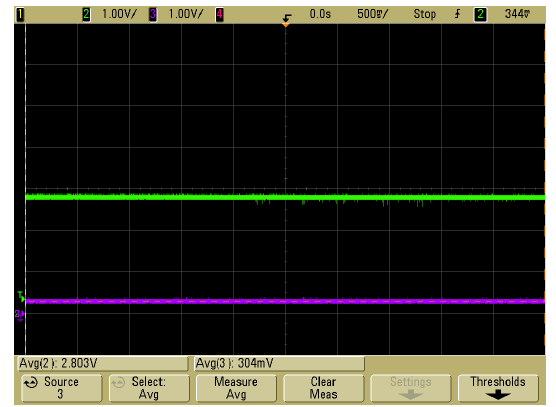
Figure 9. Response when the weight is removed.